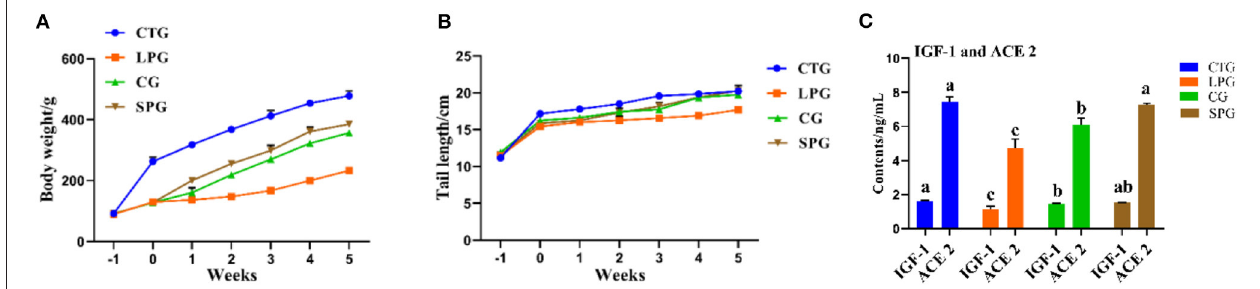
FIGURE 1 | Diet intervention alleviated the physiological condition of rats. (A) The body weight of rats. (B) The tail length of rats. (C) IGF-1 and ACE 2 contents in the serum. Data are presented as mean ± SEM. Different letters indicate statistical differences among the groups ( p < 0.05). IGF-1, insulin-like growth factor-1; ACE 2, angiotensin-converting enzyme-2; CTG, control group; LPG, low protein group; CG, casein group; SPG, soy protein